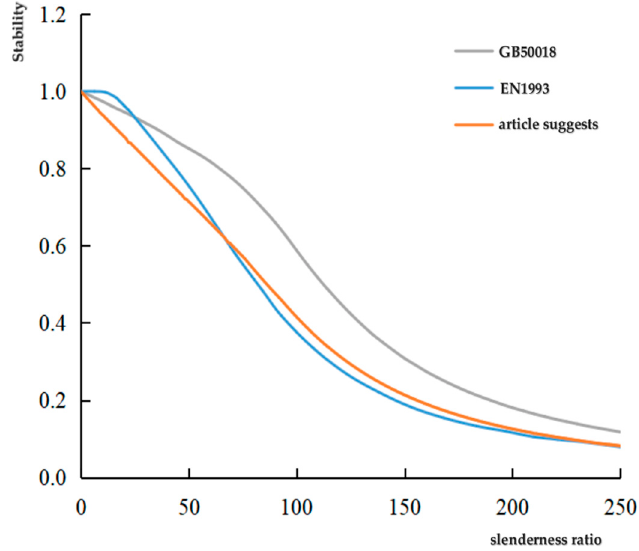
Figure 9. Comparison of proposed stability factor with code GB 50018 and European EN 1993.